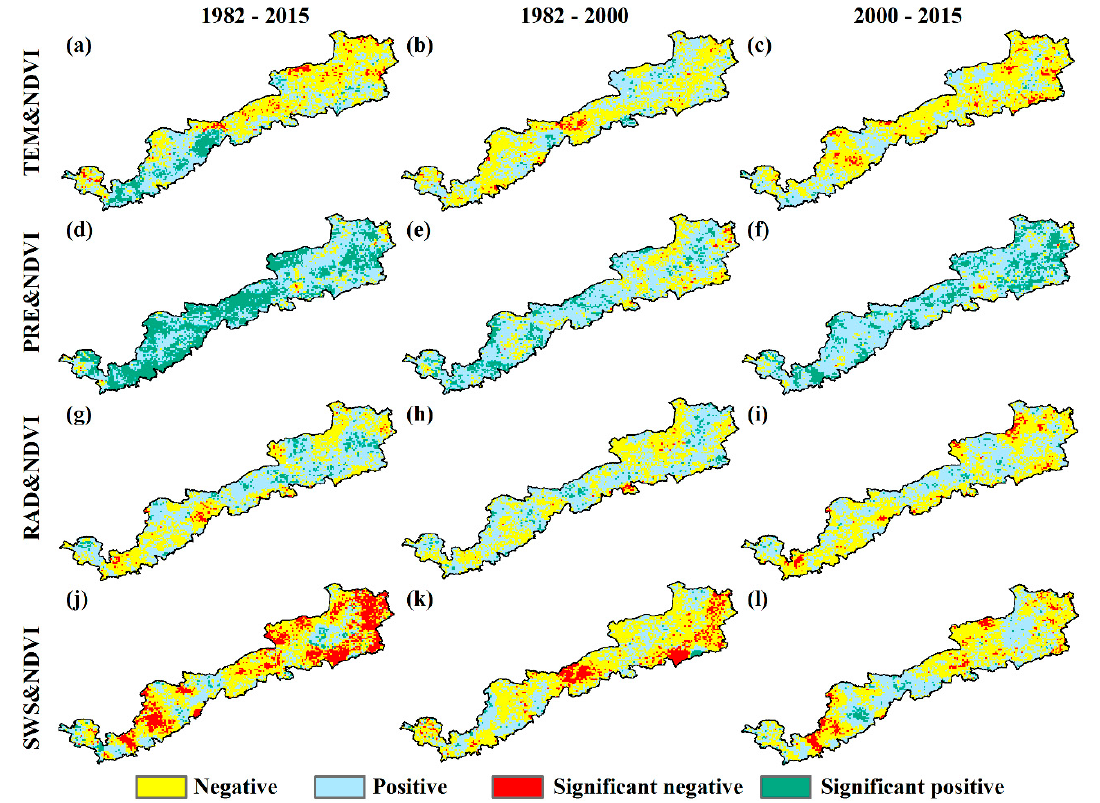
Figure 12. Spatial distribution of partial correlations between the NDVI and relevant climatic factors (TEM ( a – c ), PRE ( d – f ), RAD ( g – i ), and SWS ( j – l )) in the APENC from 1982 to 2015 (significance level at P < 0.05).